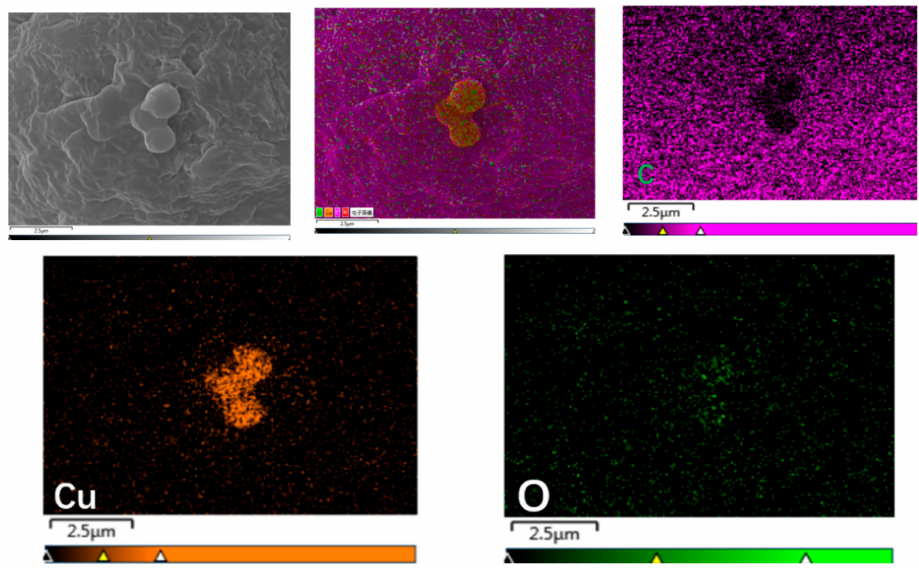
Figure 5. SEM images mapping of 0-Cu 2 O / PP composites, energy-dispersive X-ray spectroscopy (EDS) / SEM mapping for elements C, Cu and O.